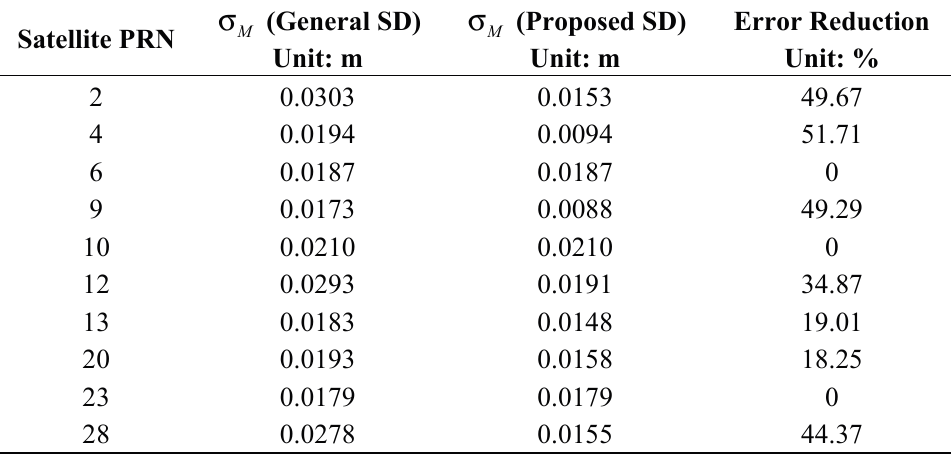
Table 8. Standard deviation of monitoring